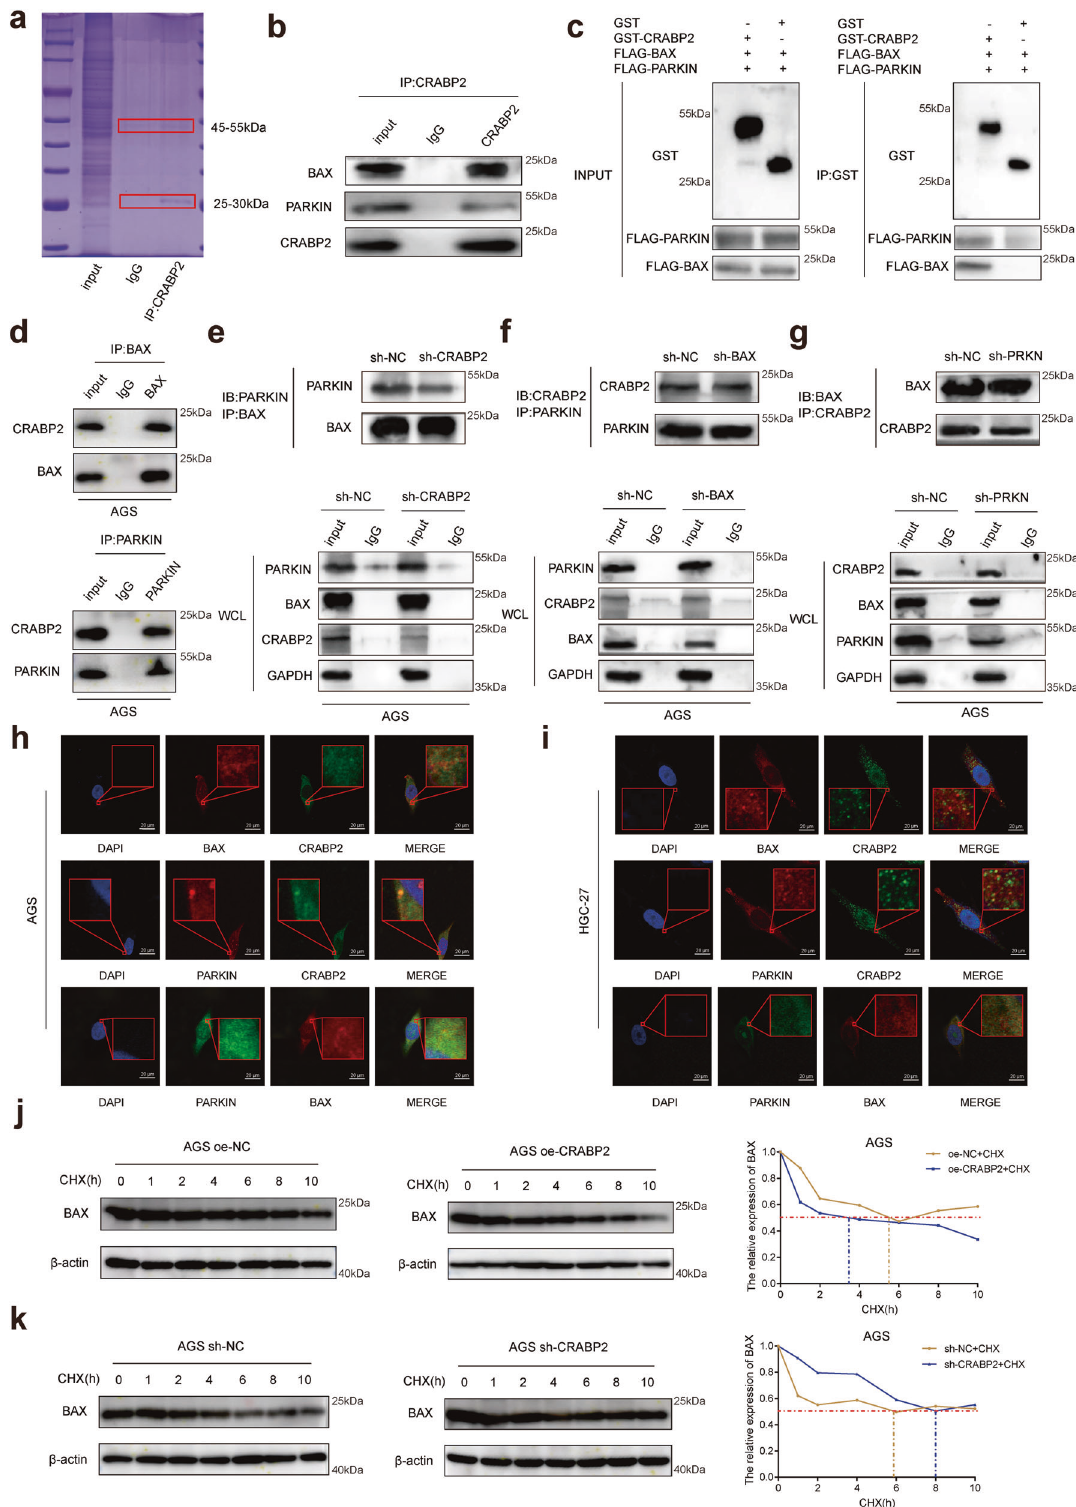
cytochrome C and cell apoptosis [37]. Furthermore, to verify the OXA resistance mechanisms of CRABP2, we performed rescue experiments in vitro and in vivo. The results showed that CRABP2 promotes OXA resistance through the BAX-dependent cell apoptosis pathway. Then we performed in vitro and in